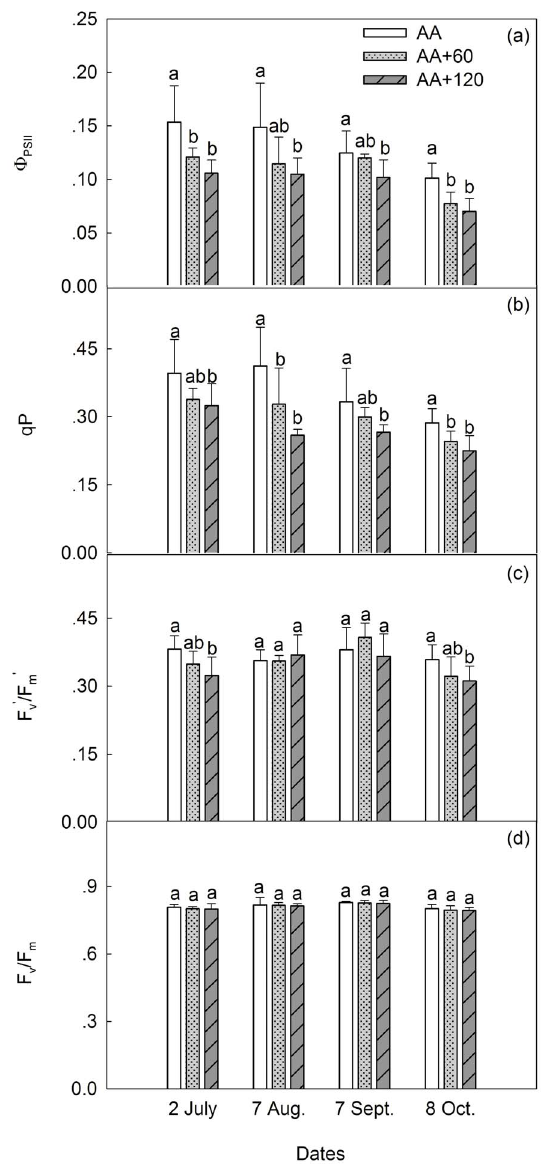
Figure 3. Effects of elevated O 3 on the chlorophyll a fluorescence parameters. Vertical bars represent average levels and distinct letters indicate significant differences among O 3 regimes ( n =6) (AA: ambient air; AA + 60: ambient air plus 60 [ppb] O 3 ; AA + 120: ambient air plus 120 [ppb] O 3 ).